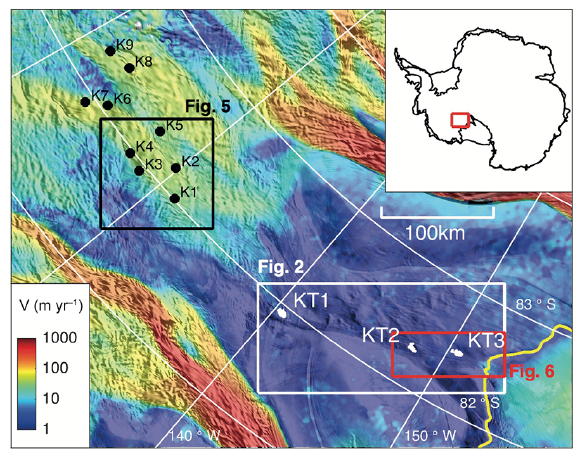
Figure 1. Locations of subglacial lakes (Smith et al., 2009) in the KIS glacial catchments, including the newly identified lakes KT2 and KT3 in the trunk of the KIS. The colored shading shows the InSAR based ice velocity from MEaSUREs (Rignot et al., 2011b) on the MODIS Mosiac of Antarctica (MOA) image (Haran et al., 2014). The white, black, and red rectangles indicate the areas shown in Figs. 2, 5, and 6, respectively. The yellow line is the grounding line from Bindschadler et al. (2011). The lake outlines (solid white lines around the KT lakes) are estimated in this